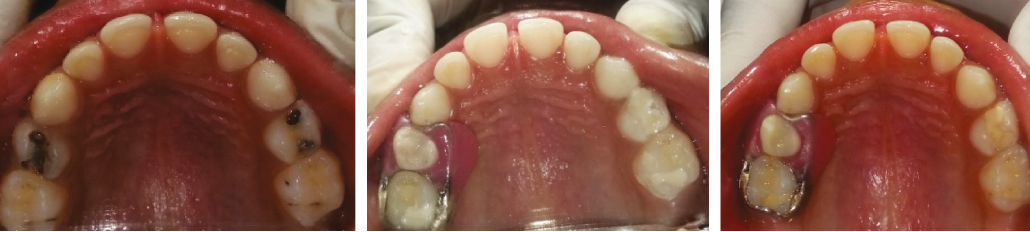
Figure 2: Preoperative, immediate postoperative, and one-year postoperative occlusal views of the maxillary arch with the functional band and loop space maintainer in the tooth 54 region.